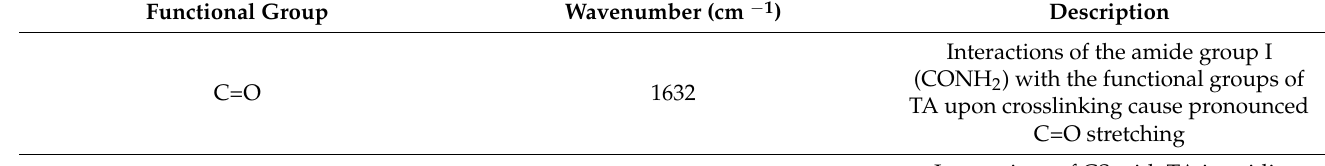
Table 2. FTIR bands of composite polymer